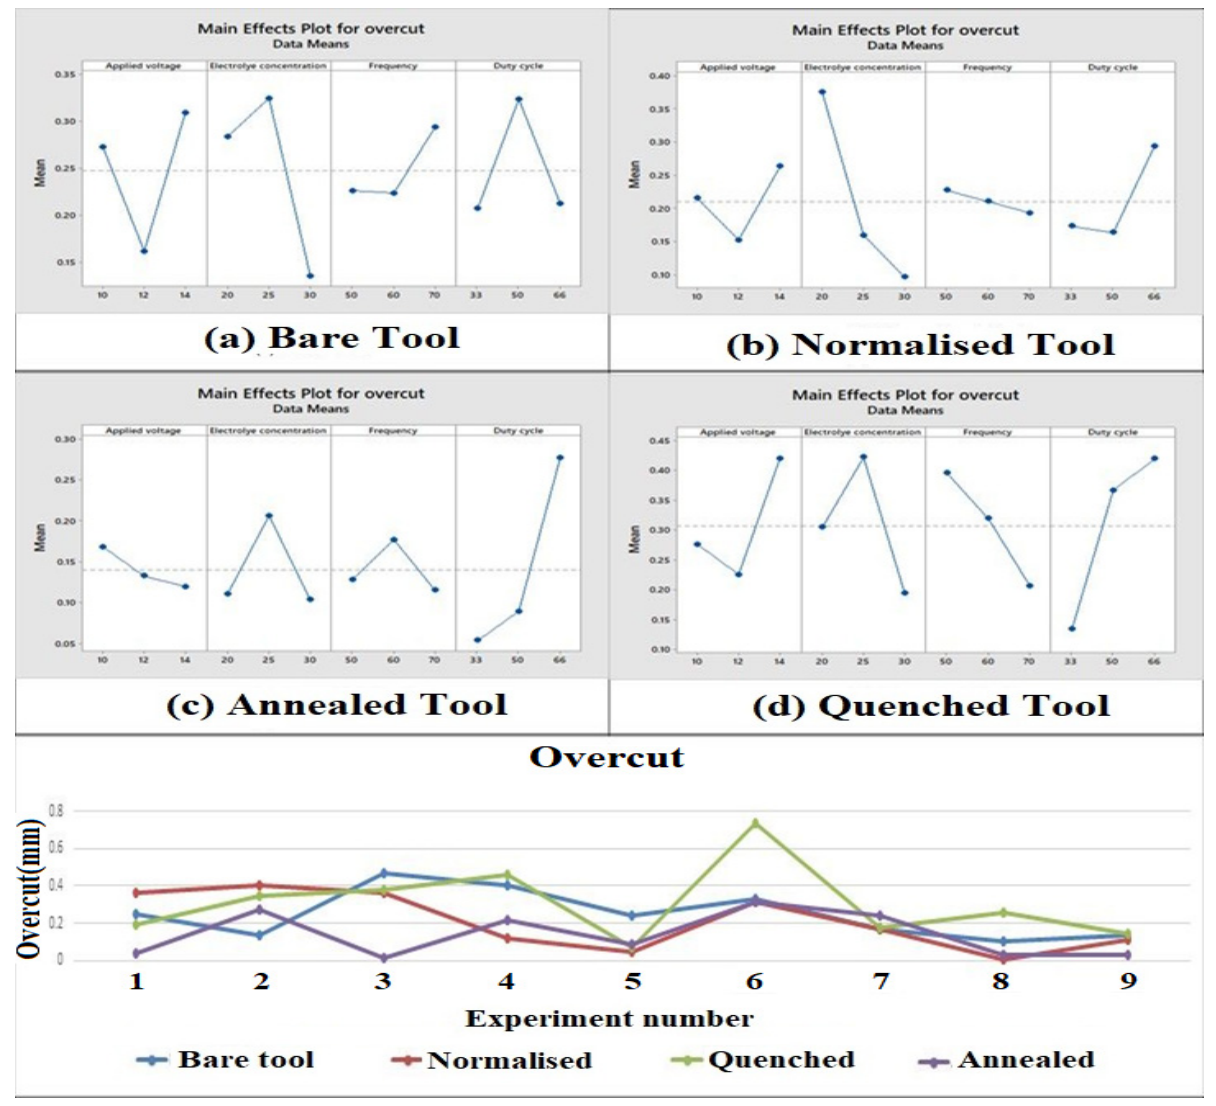
Figure 5. Main effect plots and comparison plot of overcut for tool electrodes. ( a ) Bare tool; ( b ) Normalized tool; ( c ) Annealed tool; ( d ) Quenched tool.